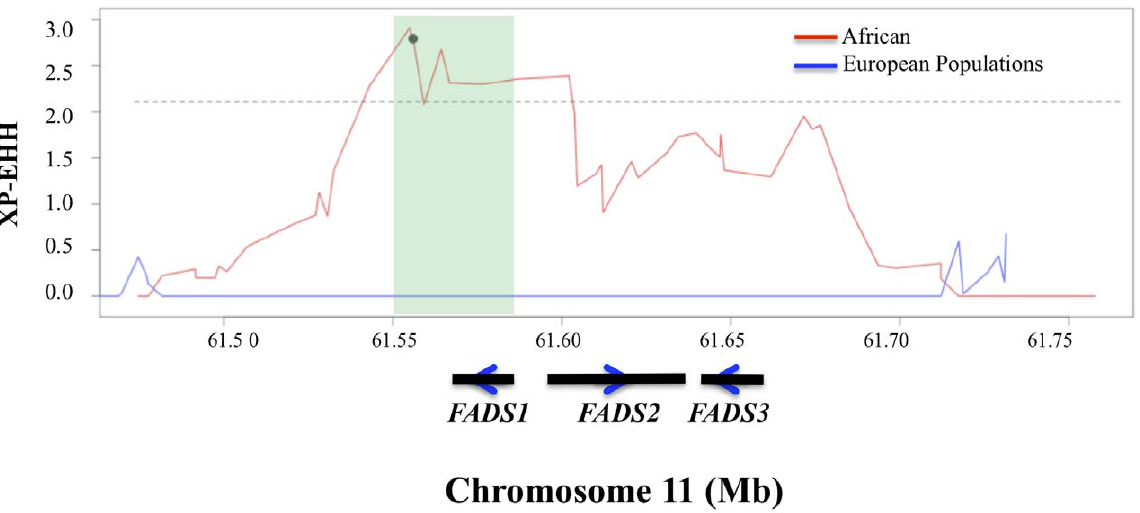
Figure 4. XP-EHH scores across the 300kb region (chr11:61467097–61759006, hg19) around the FADS gene cluster in populations from Africa (blue) and Europe (red) within the HGDP. SNP rs174737 is illustrated with the black dot on the African curve. The teal shaded box represents the , 30 kb haplotype block noted within the African samples and the three black bars represent FADS1, FADS2 and FADS3 from left to right, respectively along with direction of transcription. Dotted line represents the threshold for an empirical P=0.01 comparing across all windows in the genome for XP-EHH.